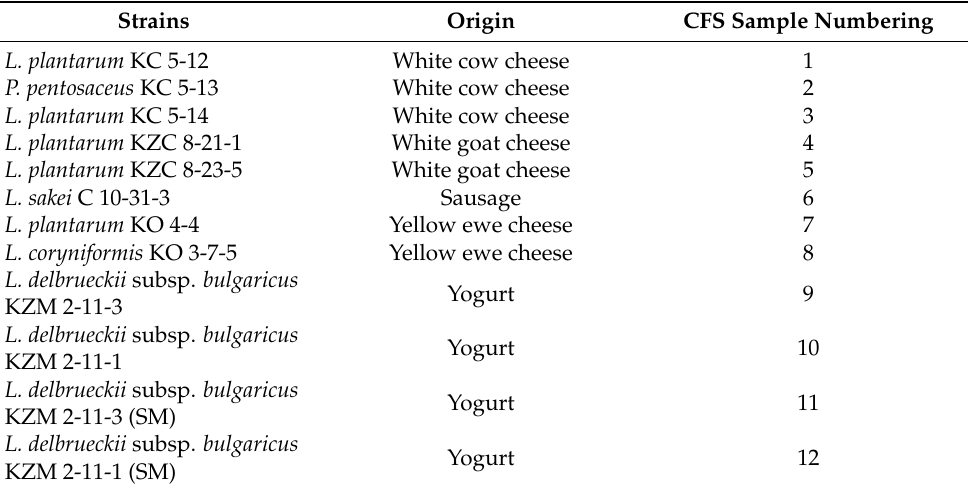
Table 1. Studied strains of lactic acid bacteria from different traditional fermented foods and CFS sample numbering. Strains Origin CFS Sample